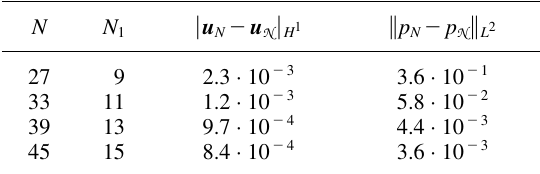
Table 1. The reduced basis error on a generic multi-block pipe with three blocks. N (cid:1) 3 N 1 is the total number of degrees-of-freedom in the reduced basis spaces X 0 , X e , and N N M N . N 1 is the number of basis geometries used to generate the basis functions.